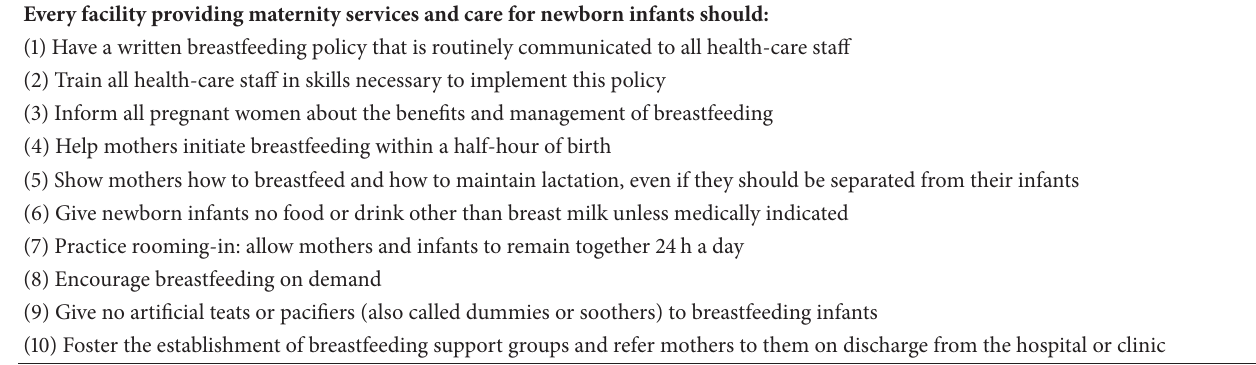
Table 1: The ten steps to successful